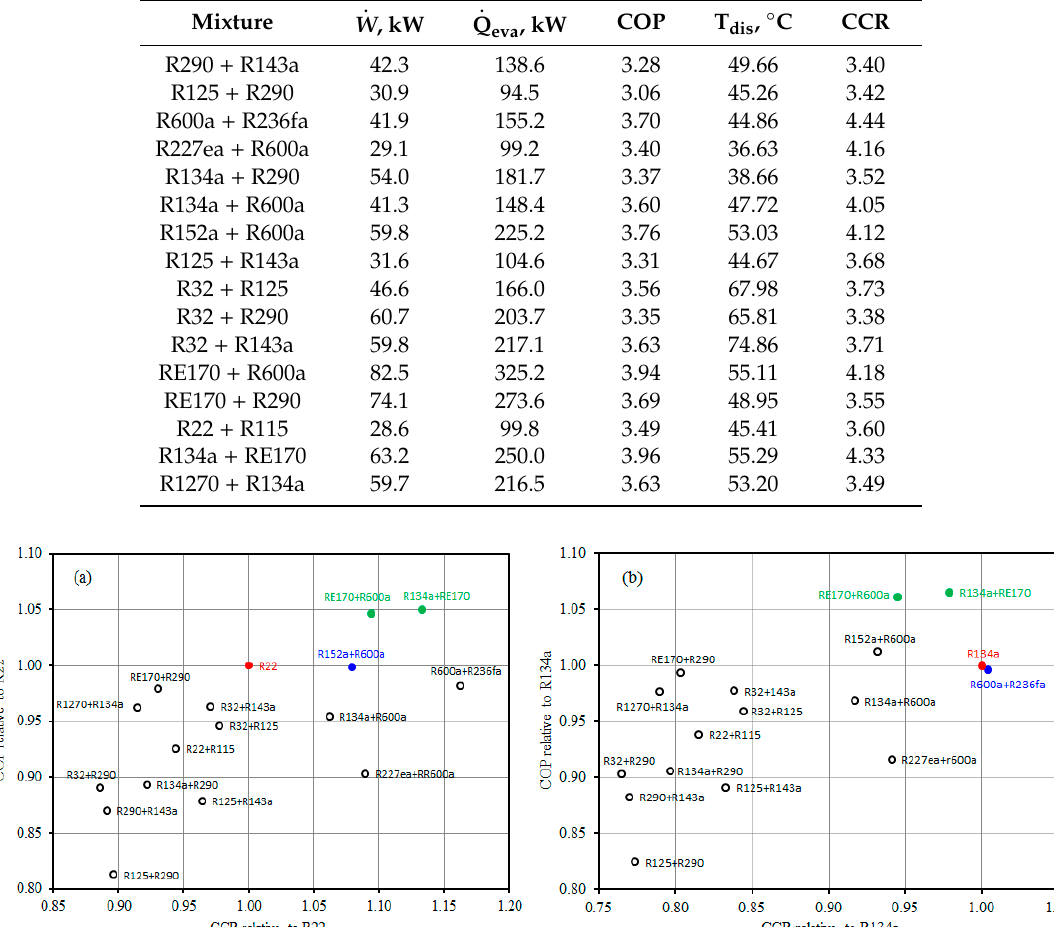
Table 4. Results for VCRC using investigated mixtures.